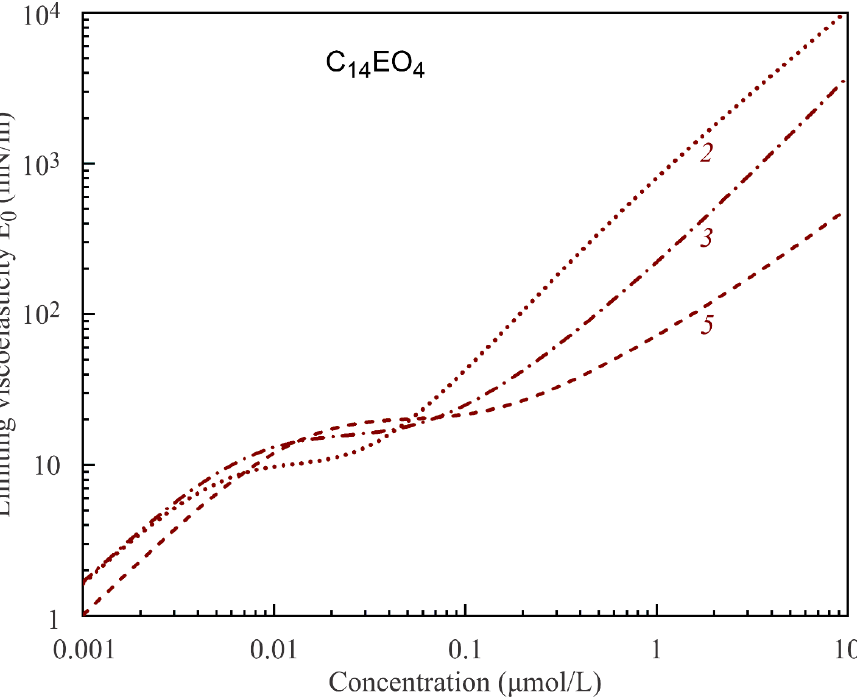
Figure 4. Limiting elasticity E 0 for C 14 EO 4 solutions calculated assuming various number of states s with the parameter sets presented in Table 1. For details see text.